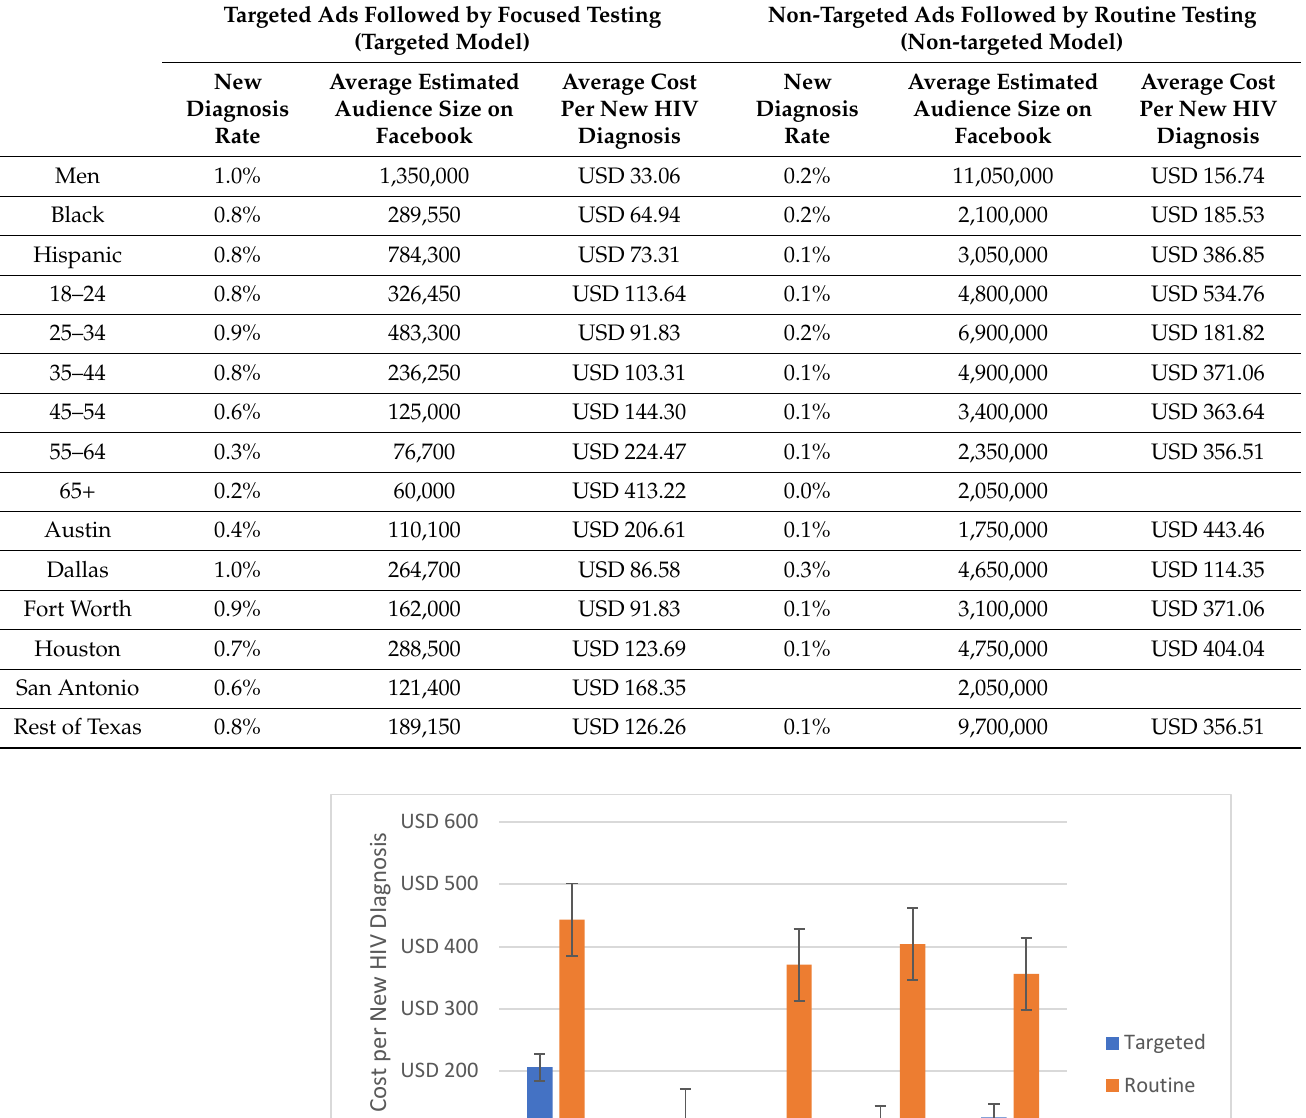
Table 1. Average Ads cost per new HIV diagnosis among targeted and non-targeted models in